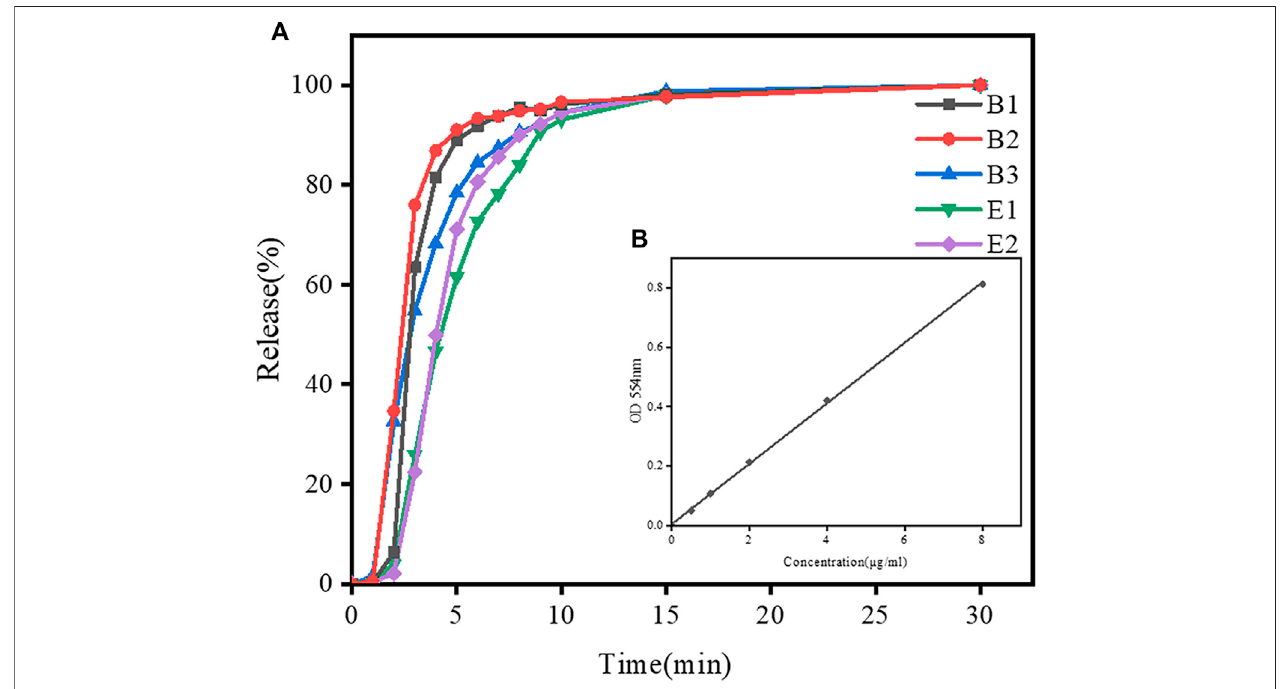
FIGURE 5 | Dissolution pro fi les of simulated drugs from different gelatin capsules within 30 min in disintegration test in DI water. (A) Drug release curves of B2 and E2 capsules in disintegration test. (B) The standard curve of Rhodamine B absorbance.